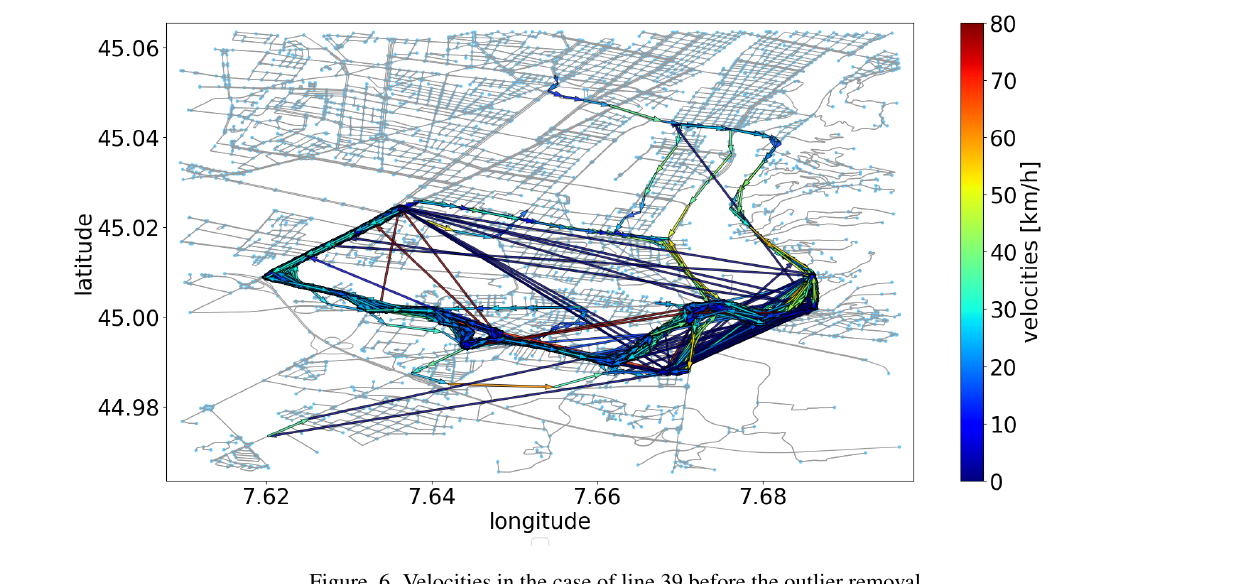
Figure 6. Velocities in the case of line 39 before the outlier removal.